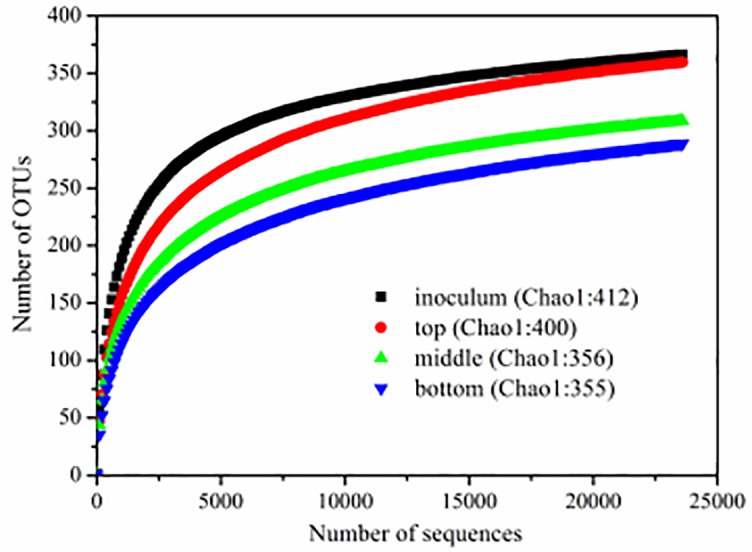
Rarefaction curves based on 16S rRNA gene sequencing of the samples (from top, middle and bottom layers) and the initial inoculum.The Chao1 index is also shown. The OTUs were defined by a 97% cutoff.